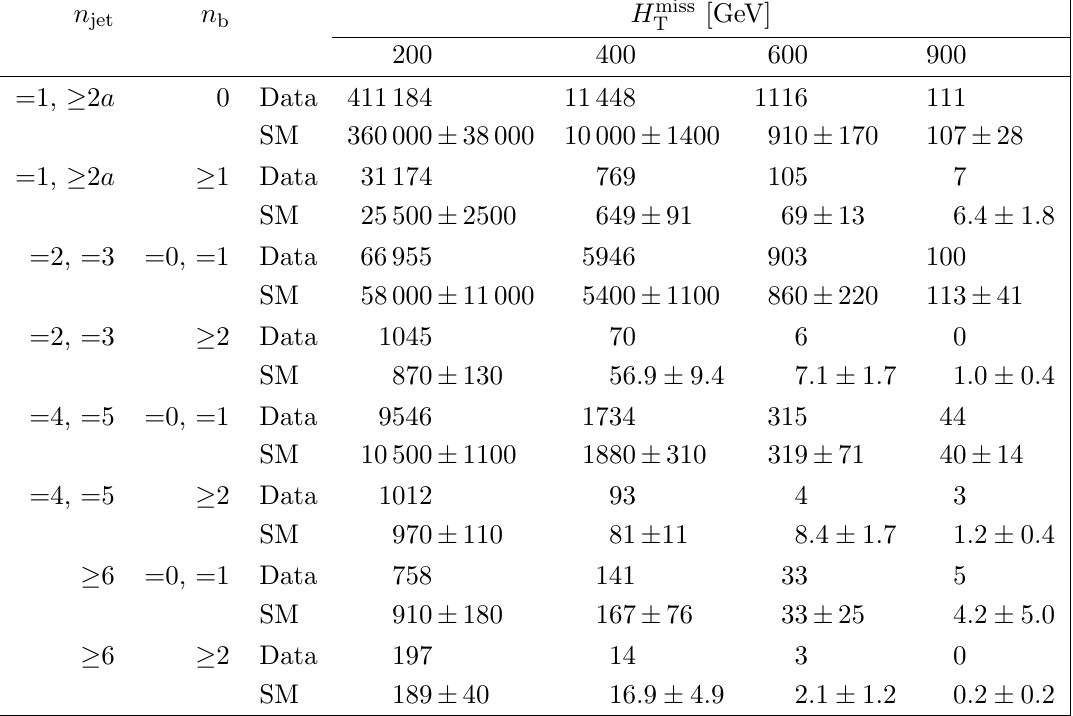
Table 7 . Observed counts of candidate signal events and SM expectations determined from the CR-only (cid:12)t using the simpli(cid:12)ed binning schema, as a function of n jet , n b , and H miss integrated over H T . The uncertainties include both statistical and systematic contributions. The a denotes asymmetric p T thresholds for the two highest p T jets.